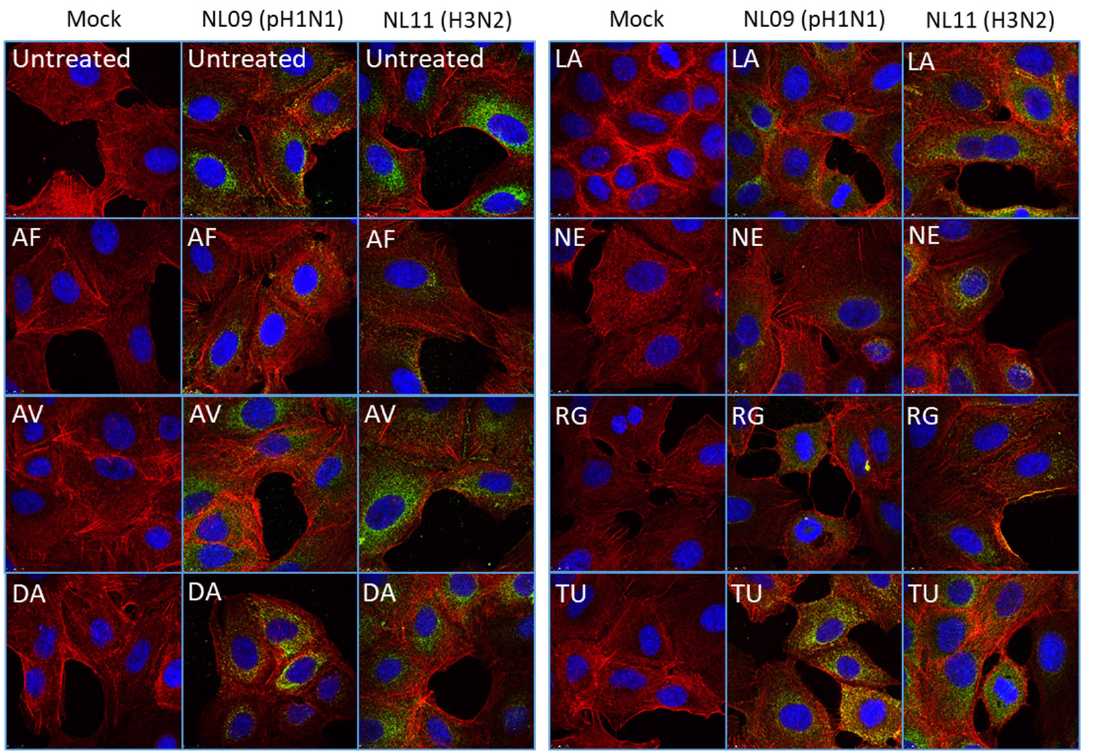
Figure 3. SMKI ‐ specific effects on viral entry. A549 cells were pretreated with SMKIs for 2 h and then infected with either the NL09 or NL11 strain (MOI = 10) for 30 min +/ − SMKIs [1×] max . Cells were fixed and permeabilized, and then virions were detected by anti ‐ NP (green) antibody, F ‐ Actin was detected by ActinRed ‐ 555 (red) and nuclei were detected using NucBlueLive ReadyProbes (blue). Virion localization was visualized by confocal microscopy (representative images from two independent experiments).